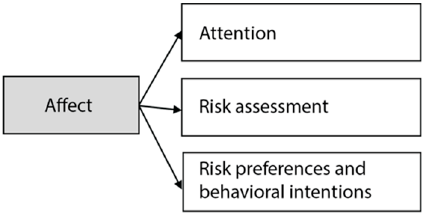
Figure 1. Theoretical framework.